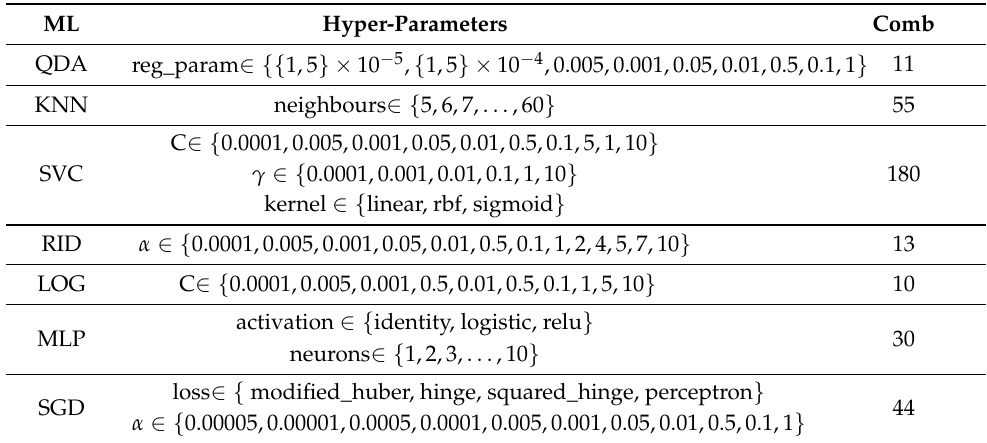
Table 1. Parameters employed in the grid search for each ML algorithm and the corresponding total number of combinations (Comb) considered in the grid